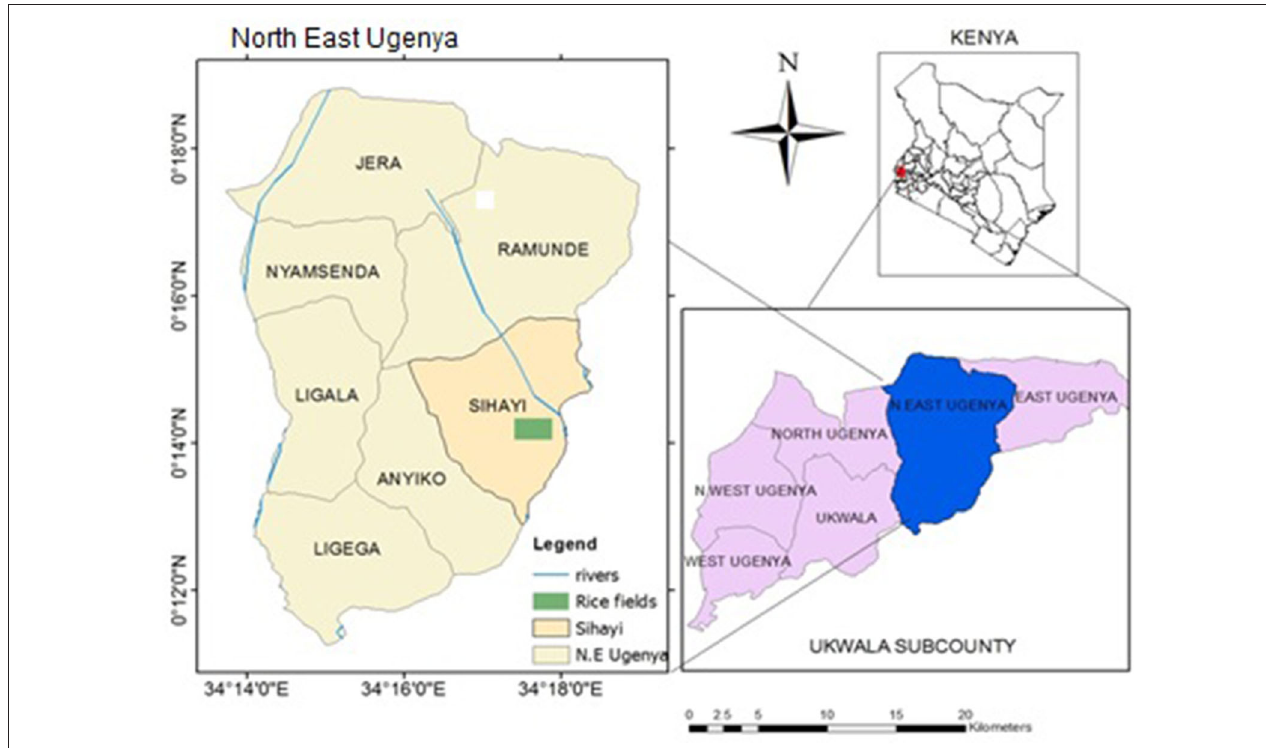
FIGURE 1 | Map of Kenya showing the location of Anyiko rice fields (Modified from Topographical map of Kenya, scale 1:50,000).